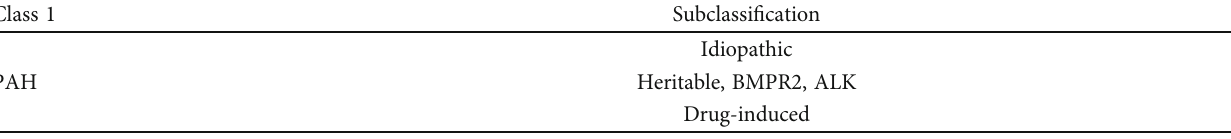
Table 2: Classi fi cation of pediatric pulmonary hypertension [3, 5, 19]. ∗ denotes causes in the pediatric